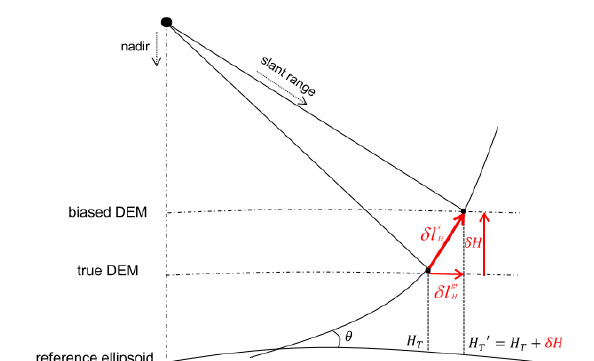
Figure 7. Range shift induced by height error (Montazeri et al., 2018)